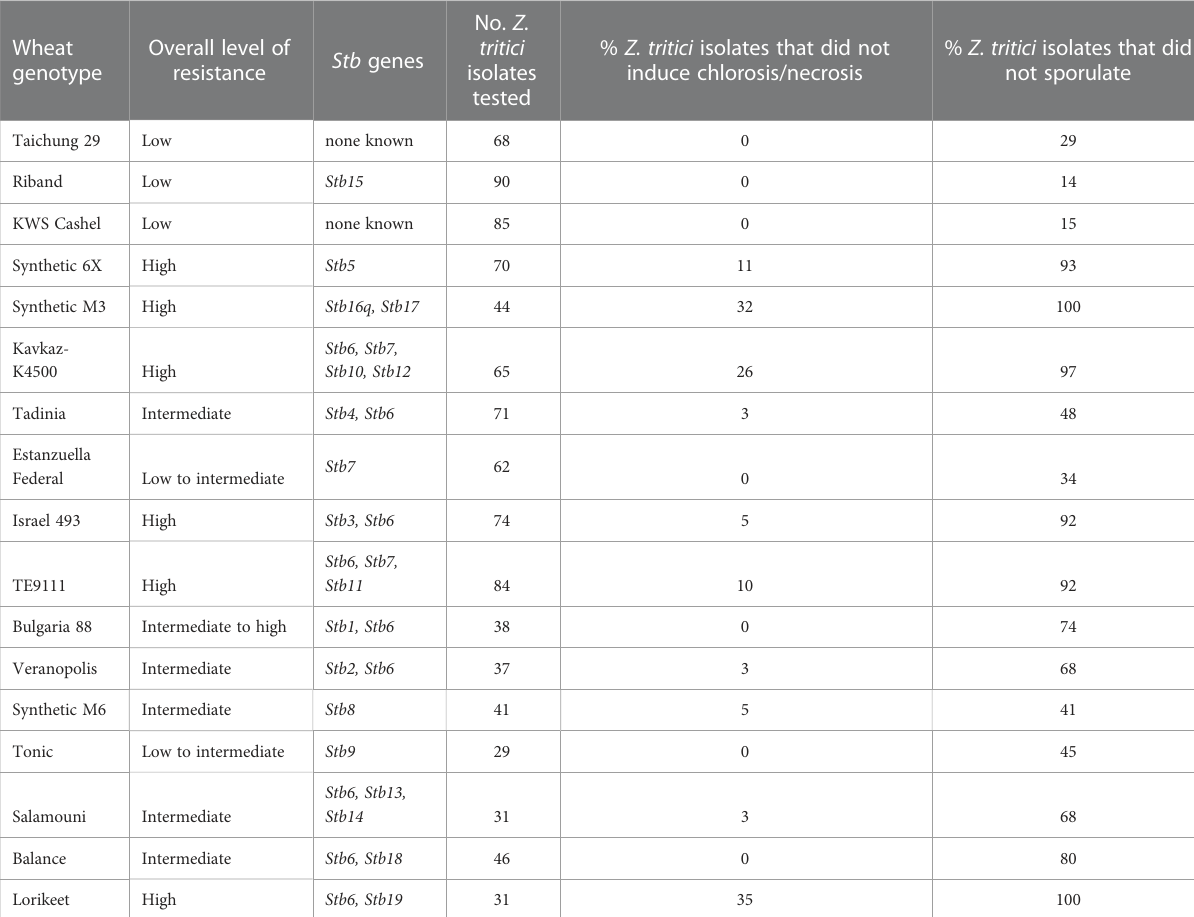
TABLE 4 The proportion of Z. tritici isolates that did not generate symptoms of each type on each wheat genotype in any interaction.